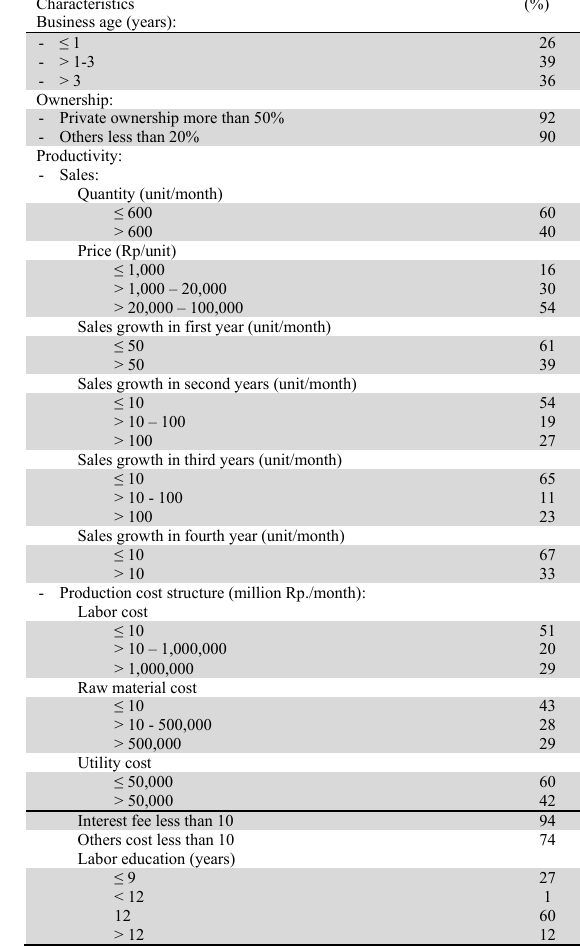
Characteristics of size Characteristics of business age, ownership, productivity